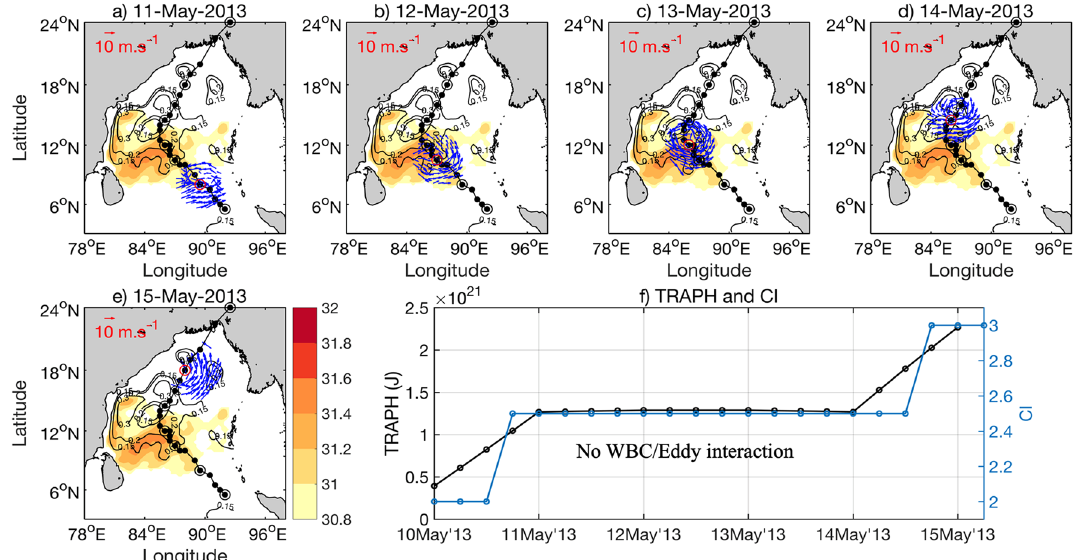
Figure 5. ( a–e ) Similar to (a–e) in Figs. 3 and 4, but for Viyaru (2013). Background shaded SST and SSHA (contours) are for 9th May 2013 (for SST > 30.8 ◦ C ). Evolution of cyclone Viyaru is shown with SST, SSH and Winds for May 11–15, 2013. ( f ) Similar to Figs. 3f and 4f, but for Viyaru. Note how the CI and Heat availability, in this case is flat during most of its evolutionary path (bottom right panel) that prevented strengthening. The maps (coastlines) are created with Matlab M_Map v1.4 toolbox (https:// www. eoas. ubc. ca/ ~rich/ map.